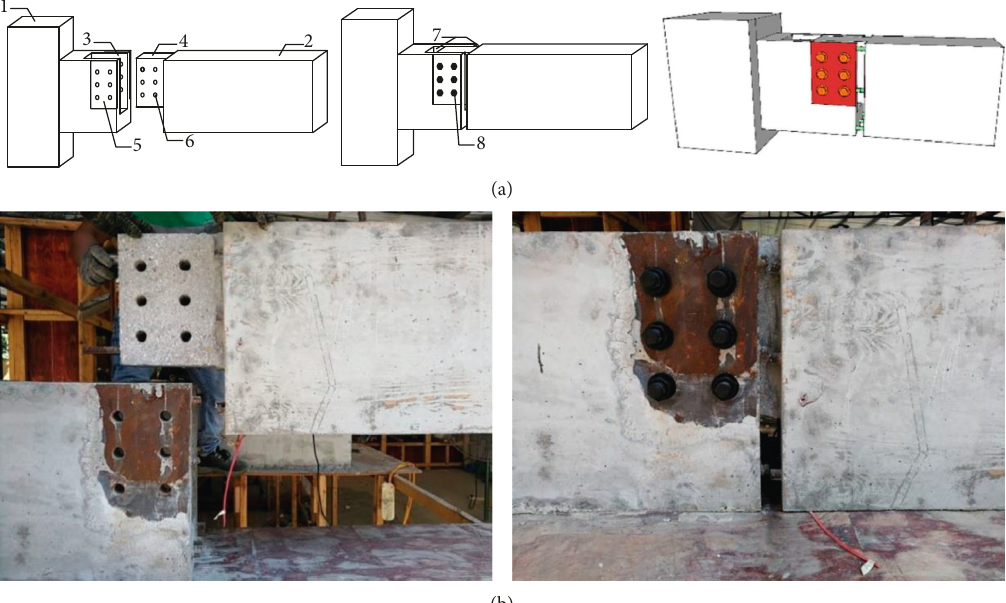
Figure 1: Beam-column joint details. (a) Design schematic diagram (1, column; 2, beam; 3, U-shaped groove; 4, corbel; 5, steel plate; 6, bolt hole; 7, cast-in-place area; 8, bolt). (b)